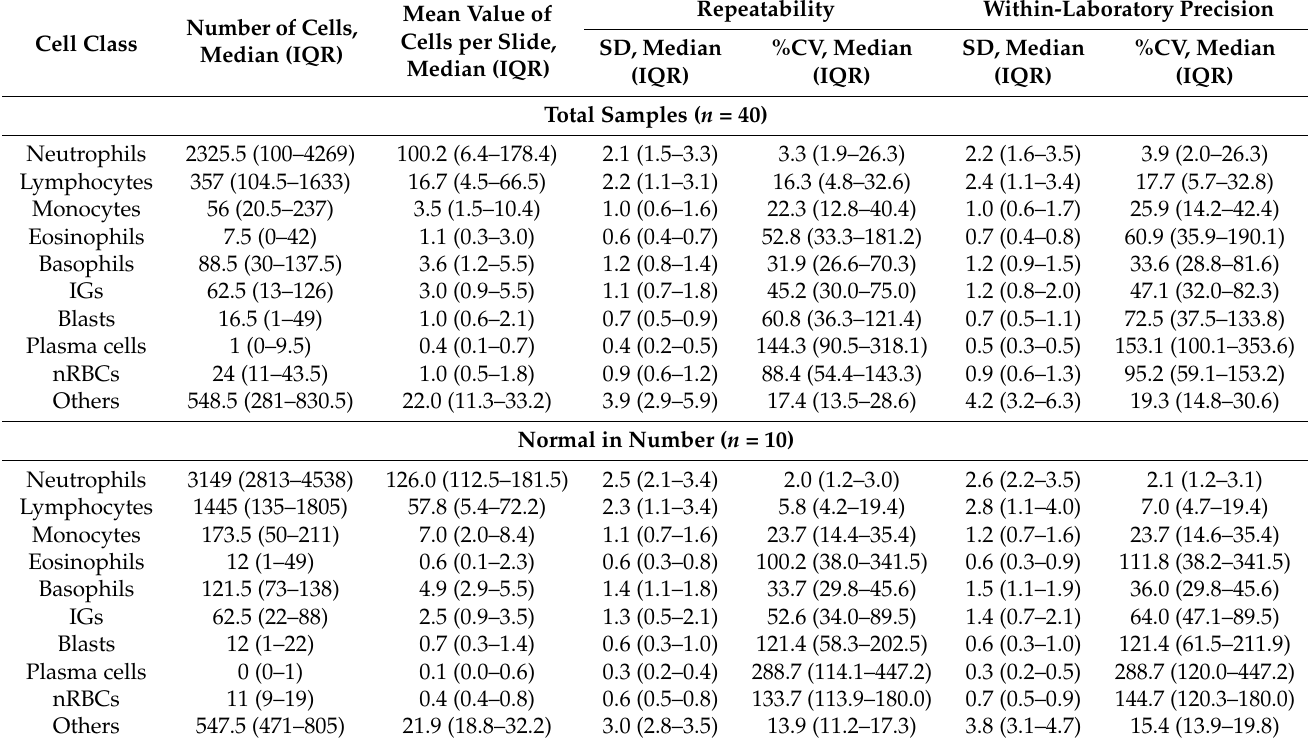
Table 2. Precision of DI-60 preclassification (5 × 5 experiment design for each